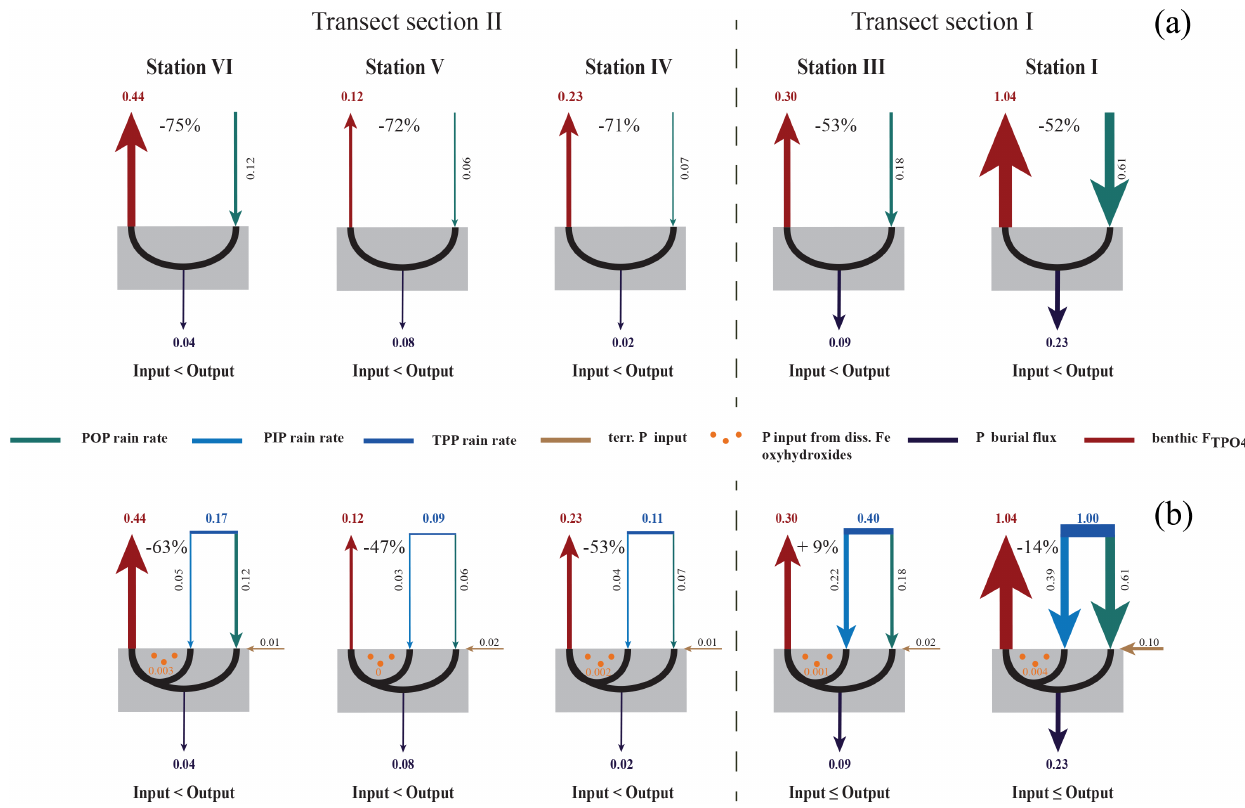
Figure 5. Mass balance calculations and measured benthic TPO 4 fluxes for stations I to VIII (74 to 407m). All fluxes are in mmolm − 2 d − 1 : (a) POP rain rates, TPO 4 fluxes, and P burial rates only. The number in percent denotes missing P needed to sustain the benthic TPO 4 fluxes. (b) Mass balance calculations including the POP and PIP rain rates, the terrigenous P input, P release from the reductive dissolution of Fe (oxyhydr)oxides and the benthic TPO 4 fluxes into the bottom waters, as well as the P burial